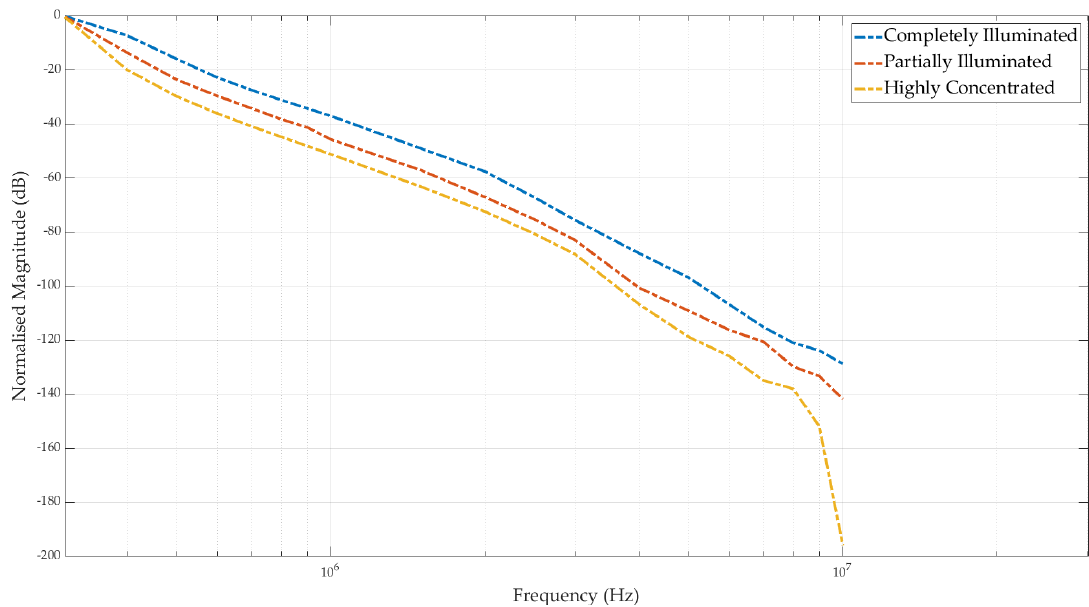
Figure 6. Frequency response of solar panel with different illumination levels.